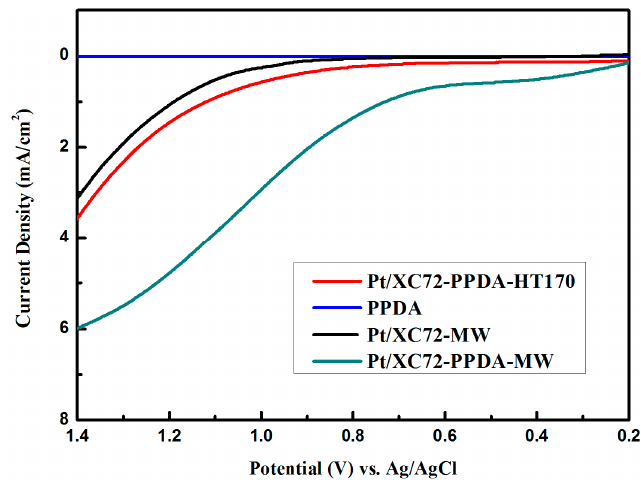
Figure 8. The ORR curves of neat PPDA, Pt/XC72-MW, Pt/XC72-HT and Pt/XC72-PPDA-MW.